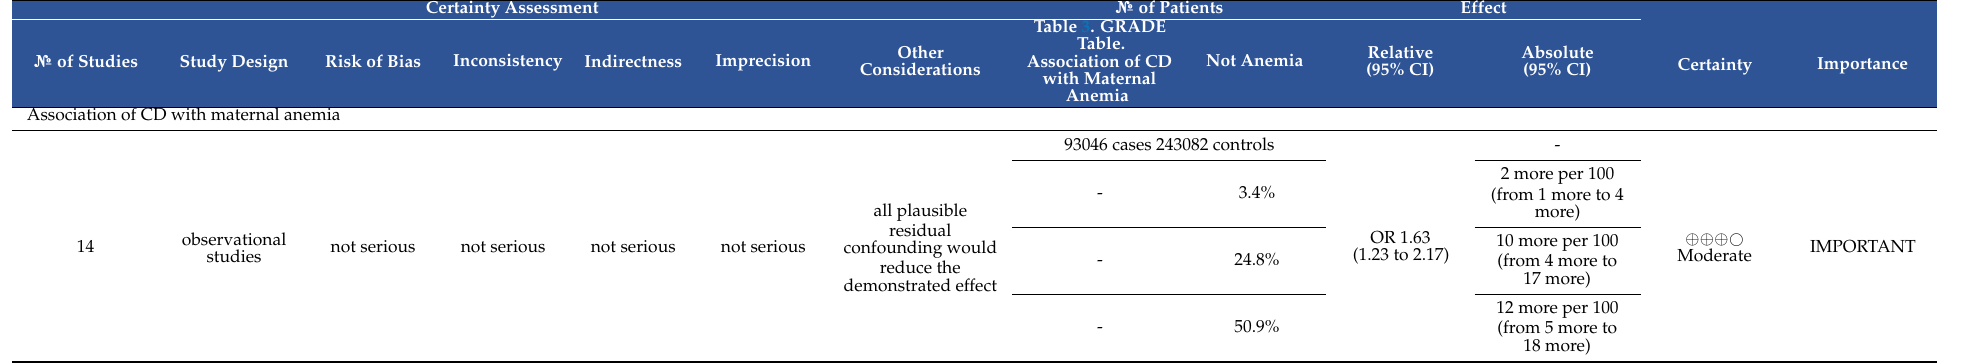
Table 3. GRADE table. Association of CD with maternal anemia compared.